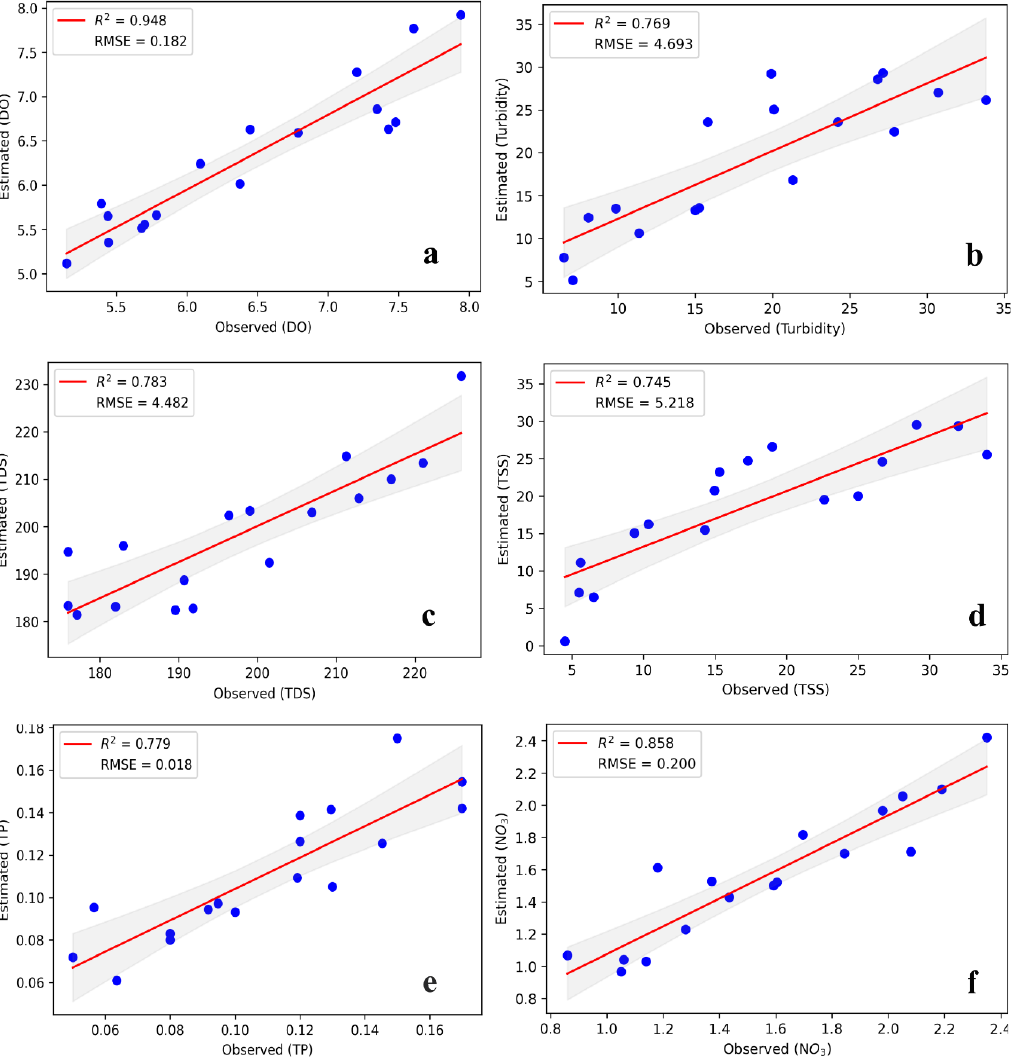
Figure 3. Correlation of observed vs. estimated data with the models. ( a ) dissolved oxygen (DO); ( b ) turbidity; ( c ) total dissolved solids (TDS); ( d ) total suspended solids (TSS); ( e ) total Phosphorus (TP) and ( f ) nitrates (NO 3 ).